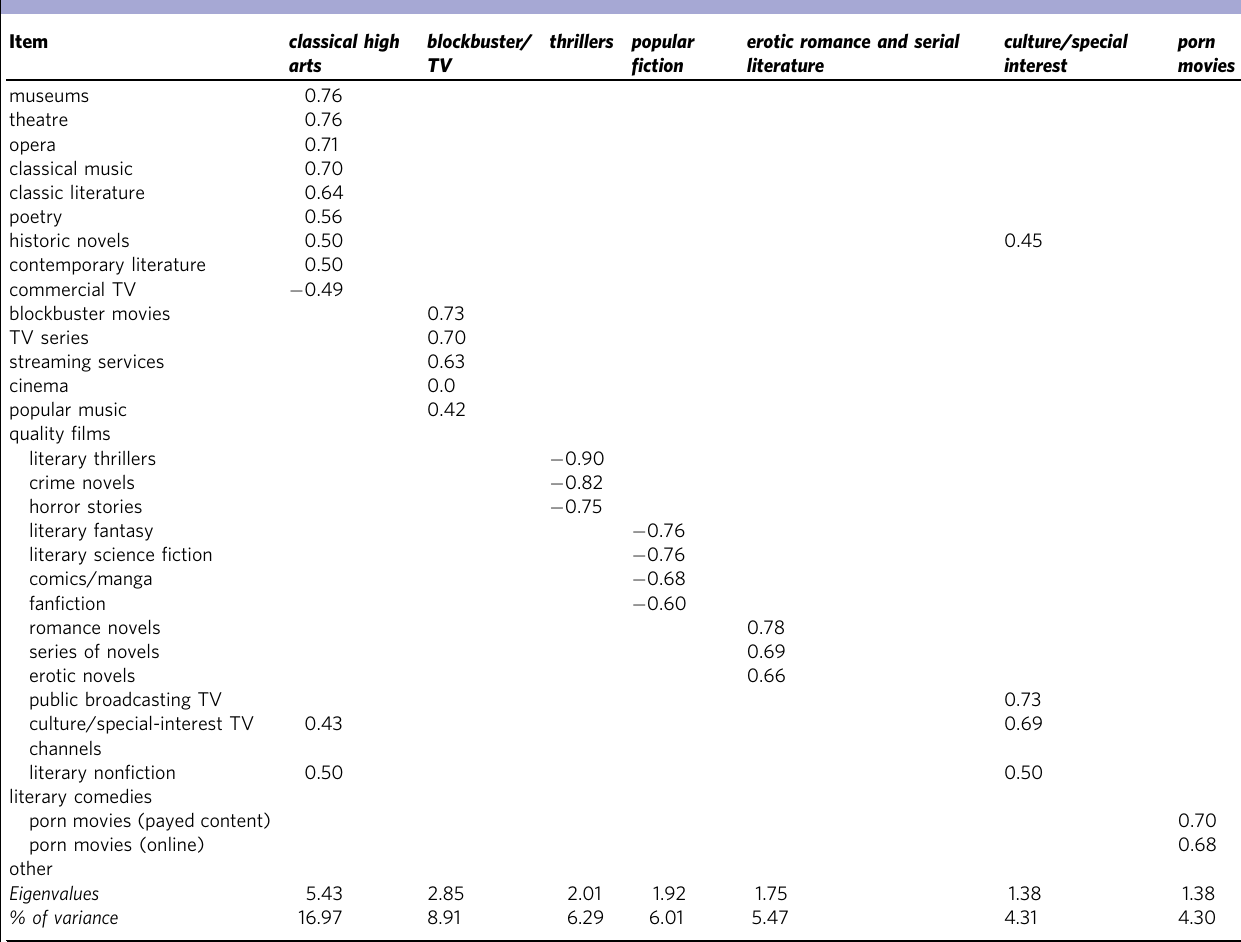
Table 3 Component loadings for a principle components analysis (PCA) with oblimin rotation of the items describing participants ’ cultural preferences and practices, including reading ( N =